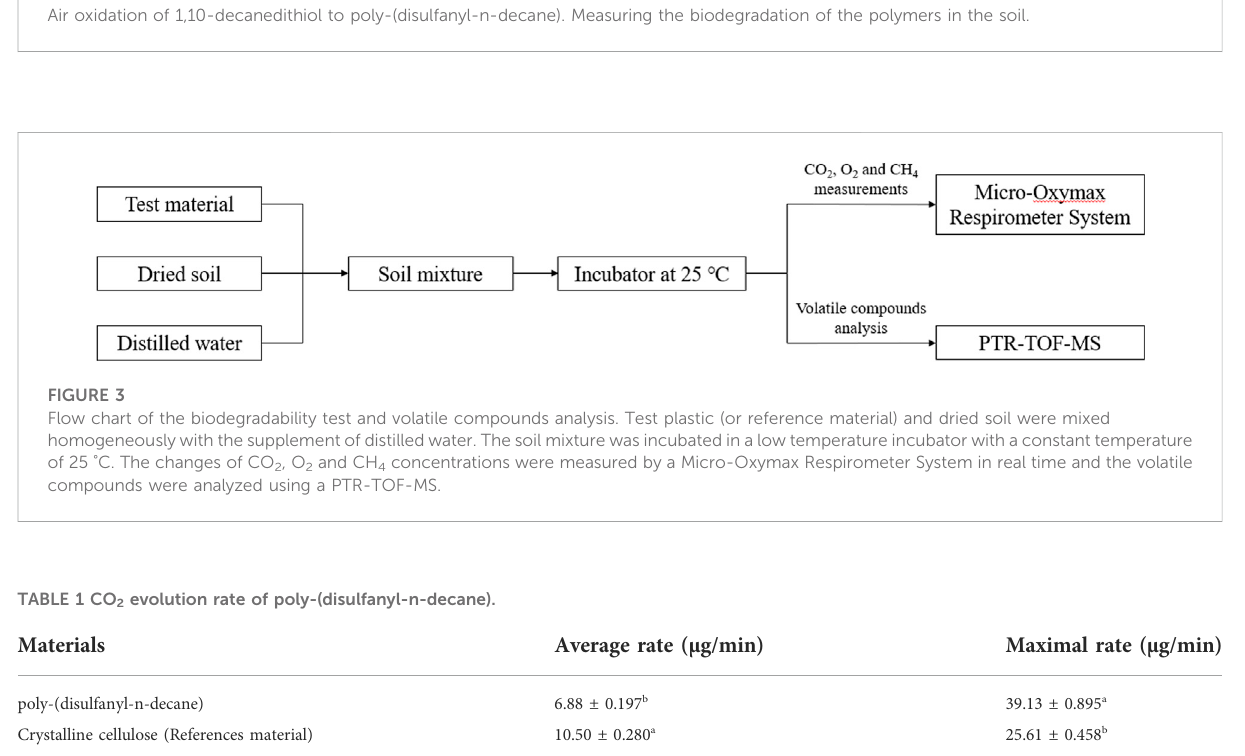
FIGURE 2 Air oxidation of 1,10-decanedithiol to poly-(disulfanyl-n-decane). Measuring the biodegradation of the polymers in the soil.